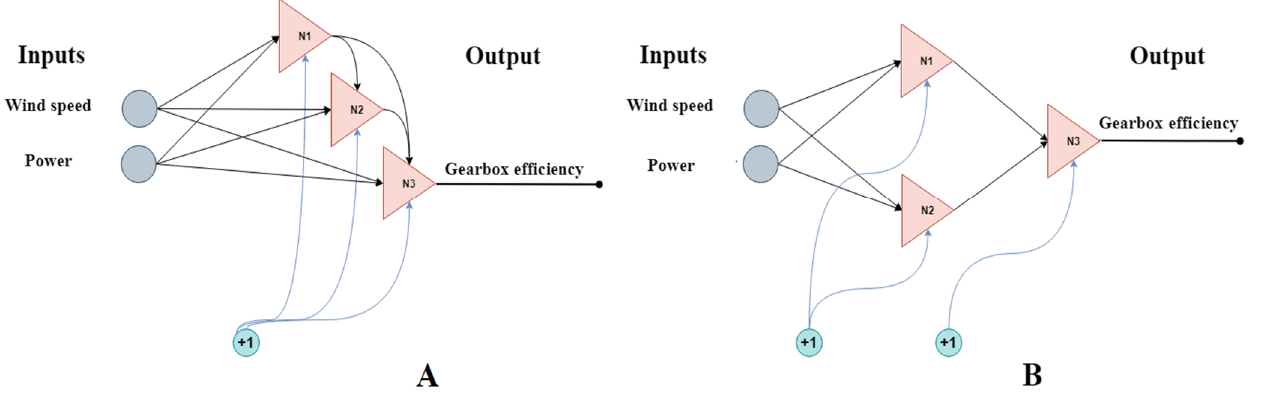
Figure 7. ANN architectures for gearbox efficiency prediction. ( A ): 2 inputs, 1 output FCN; ( B ): 2 inputs, 1 output MLP 2-2-1 (N is the neuron index).